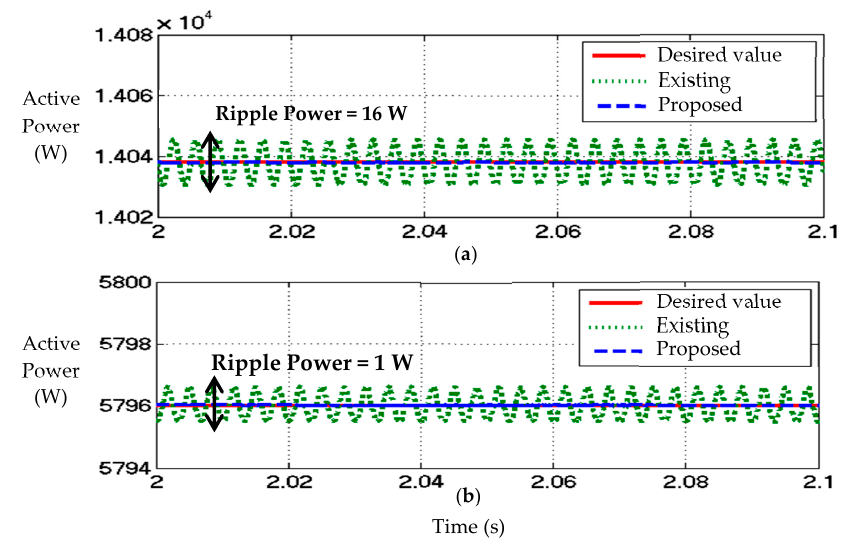
Figure 4. Fundamental element of active power p ( dc ) detected by each reference current generation algorithm for: ( a ) capacitive load; and ( b ) inductive load.